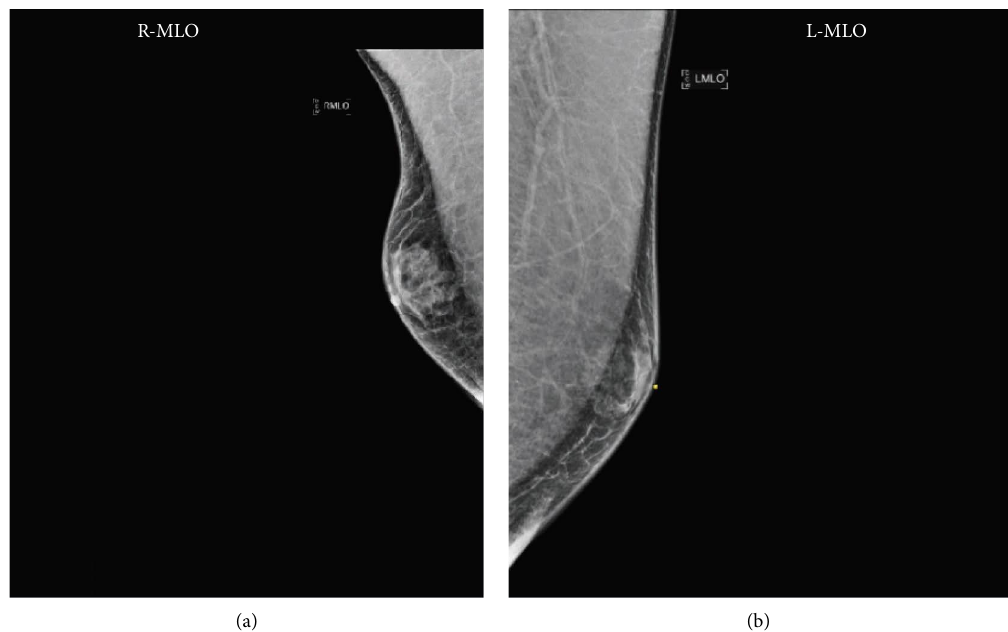
Figure 1: Magnetic resonance imaging (MRI) of the (a) right breast and (b) left breast showing fame-shaped subareolar densities consistent with